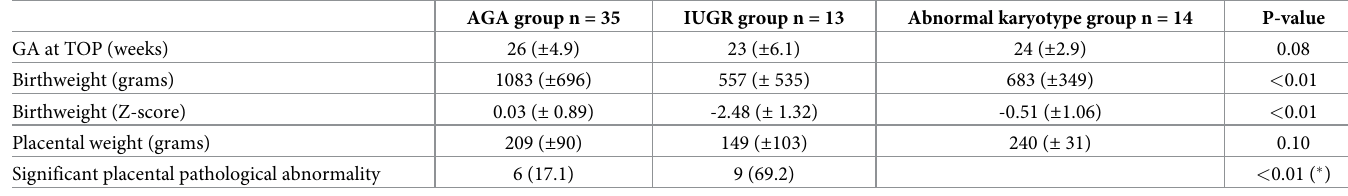
Table 1. Characteristics of the pregnancies. Three groups were compared: appropriate for gestational age birthweight fetuses AGA (n = 35); intrauterine growth restric- tion fetuses IUGR (n = 13) and abnormal karyotype fetuses (n = 14). Data were compared using t-test ( � ) to evaluate pathological abnormality or ANOVA for other